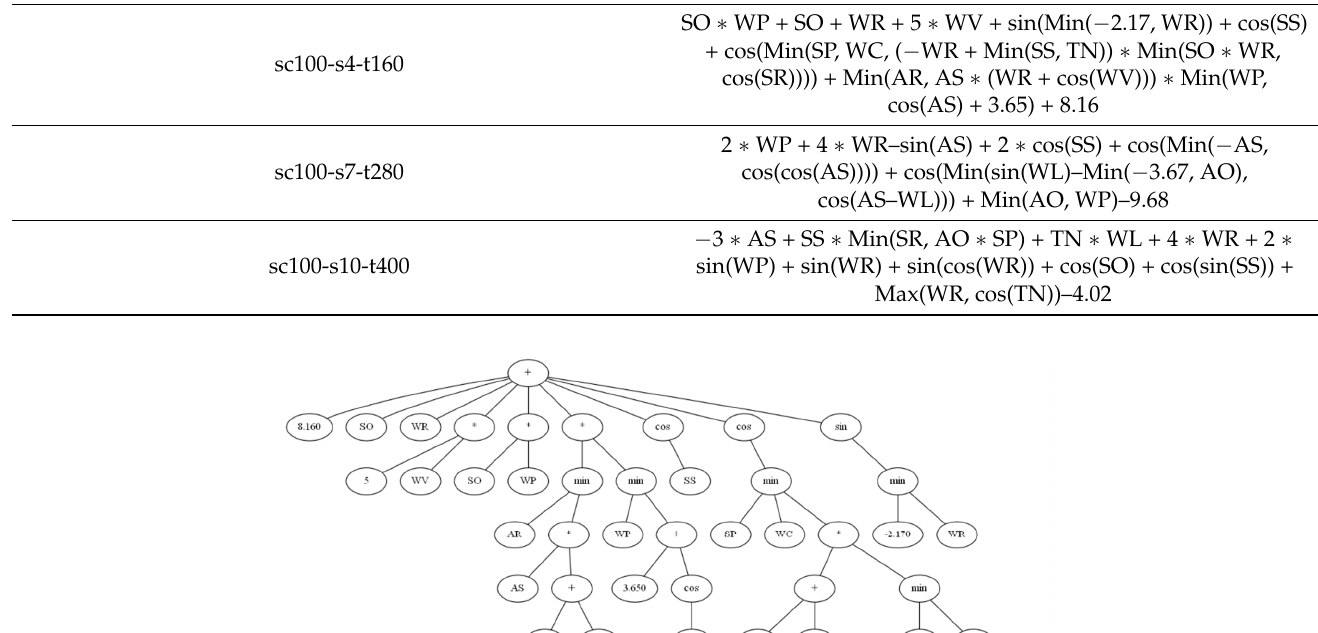
Table 7. The results of optimal evolution rules.